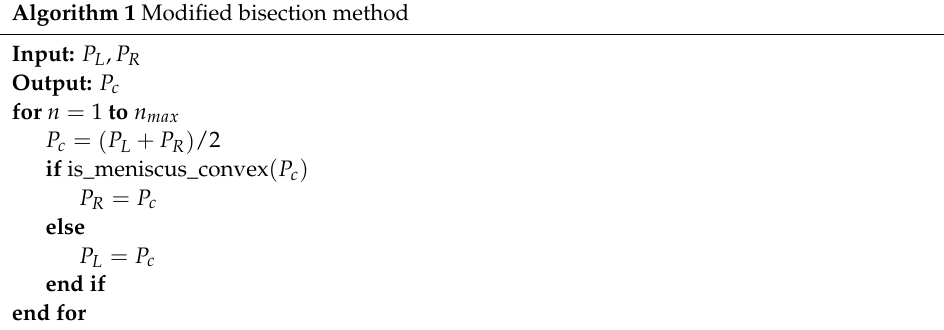
Algorithm 1 Modified bisection